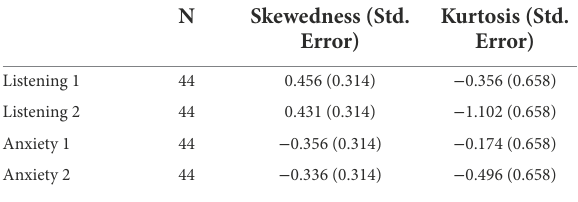
N Skewedness (Std. Error)